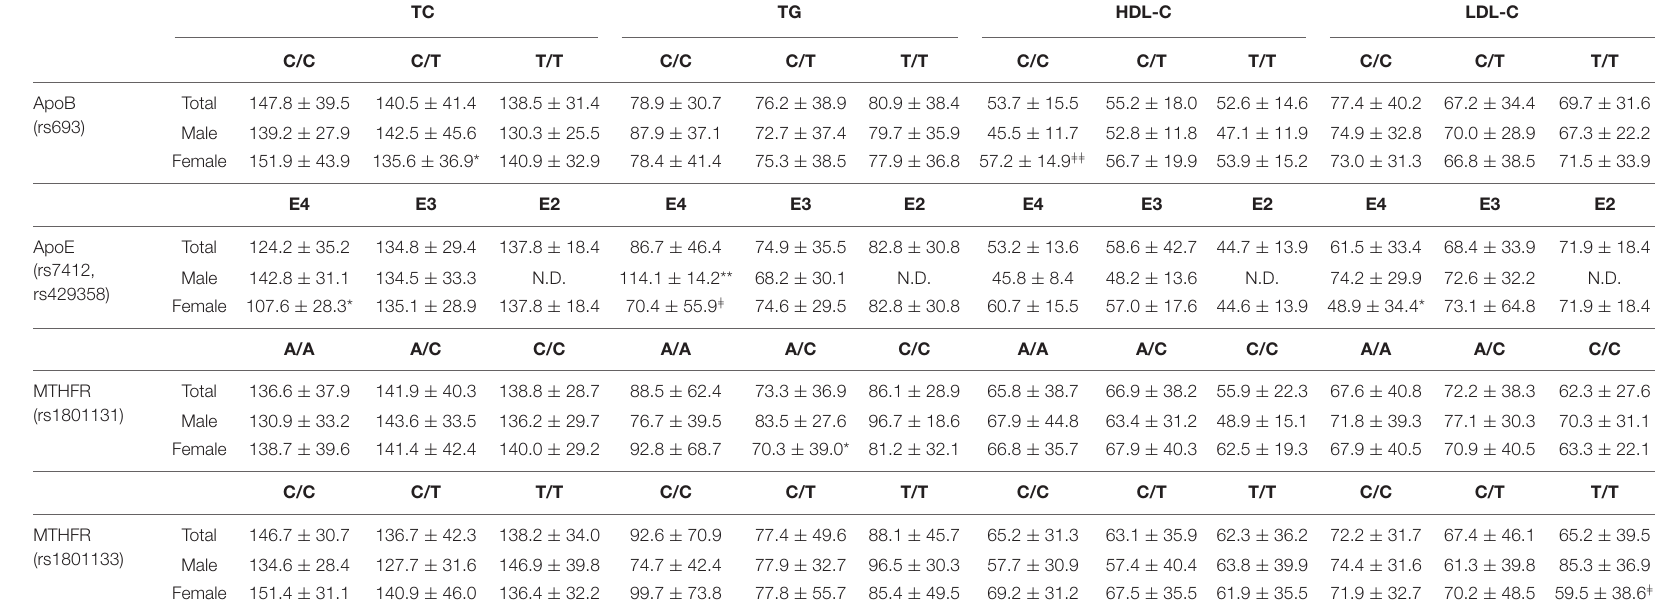
Value are expressed in mg/dl and represented as mean ± SD. The E2/E2 and E2/E3 genotypes were combined and presented as E2 carriers. Since E4/E4 individuals were absent, the E3/E4 genotype was presented as E4 carriers. The E2/E4 genotype was excluded from the analysis. Data were analyzed by one-way ANOVA, followed by a post hoc Bonferroni or Student t-test. *p < 0.05 when compared with C/C or A/A